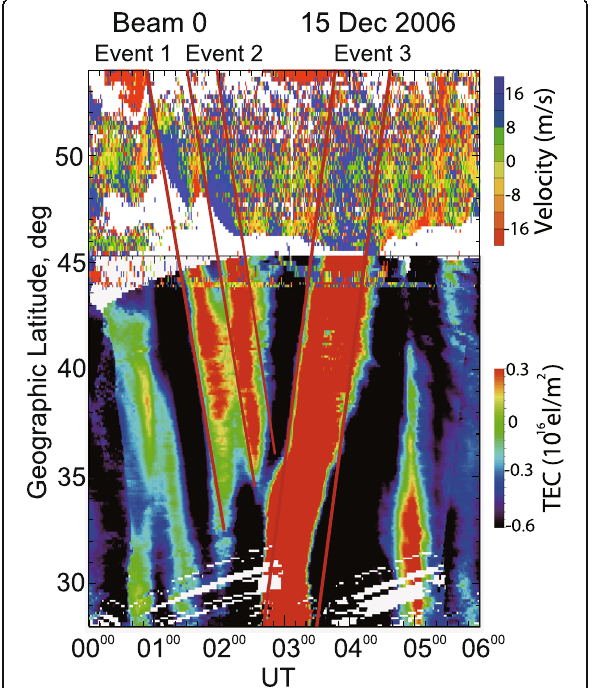
Fig. 28 LSTID signatures observed simultaneously by HOK and GEONET- GPS receiver network on 15 December 2006. The upper panel shows Doppler velocity of GS echoes measured by HOK, and the lower panel shows GEONET-GPS total electron content (TEC) perturbations (sampled along the direction of HOK beam 0 at lower latitudes) plotted as a function of UT and geographic latitude. In the lower panel, the TEC perturbation values were obtained by subtracting 60-min running average. Three major disturbances are visible in each map, denoted as events 1 – 3. Adapted from Fig. 5 of Hayashi et al.